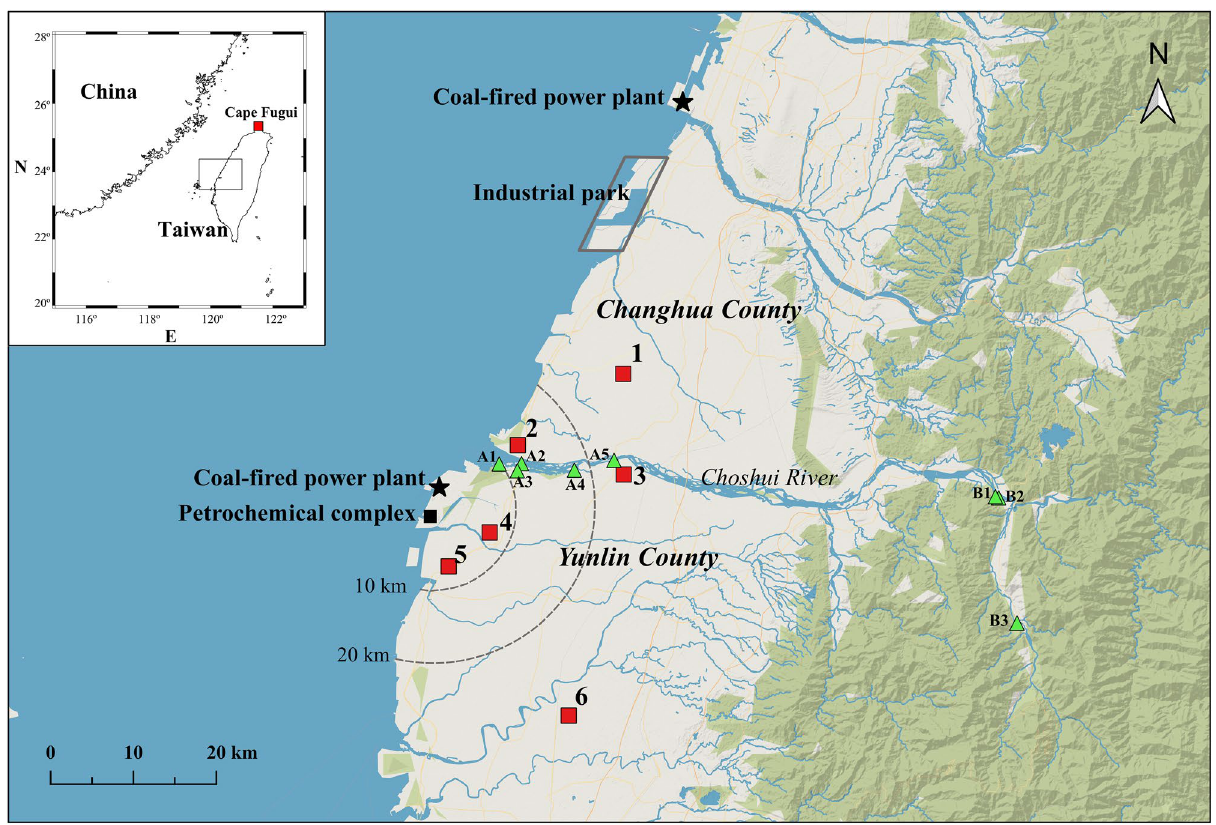
Figure 1. Map of the study area in Changhua and Yunlin Counties, central Taiwan. The red square represents the PM 10 sampling site, and the green triangle represents the sediment sampling